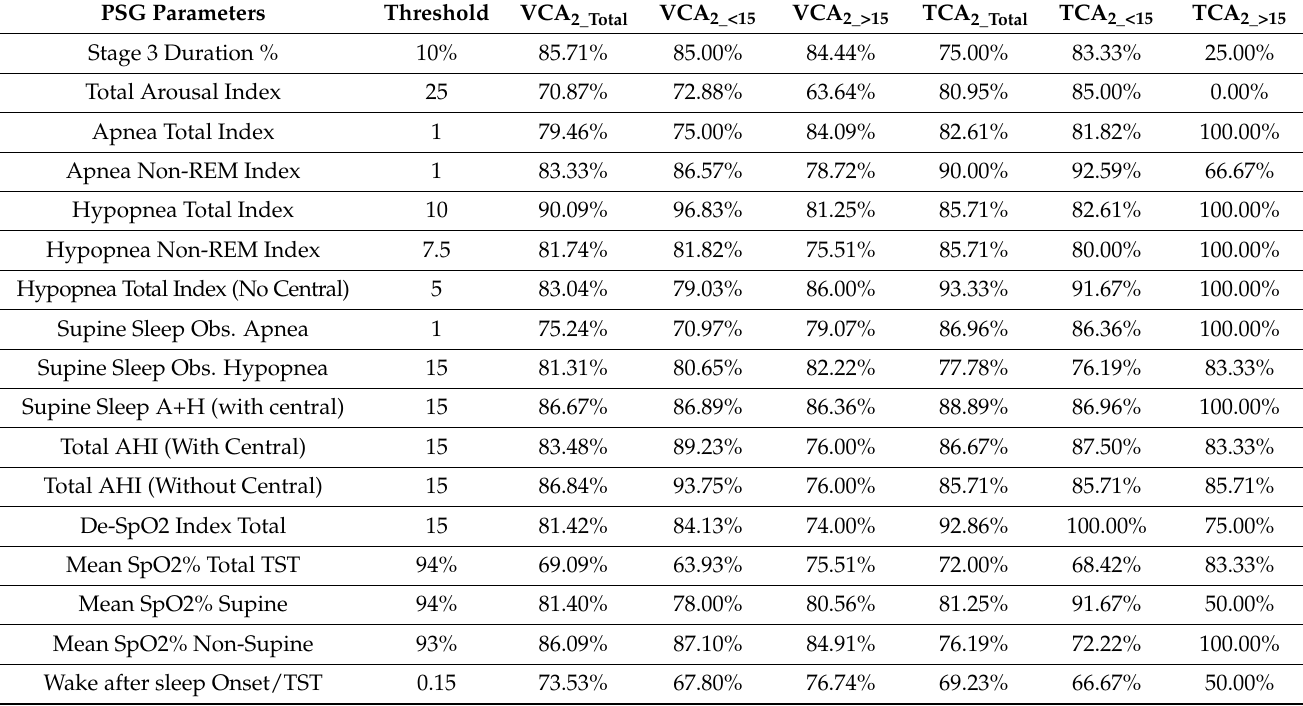
Table A2. The validation accuracy for classifying data around the selected threshold using the outcomes of the bilinear models for each of the three severity groups